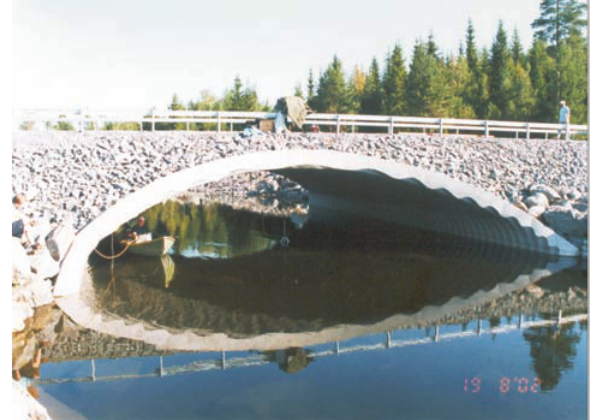
fig. 5. Side view on the soil-steel bridge made from corrugated plates (in Sweden) (Manko, Beben